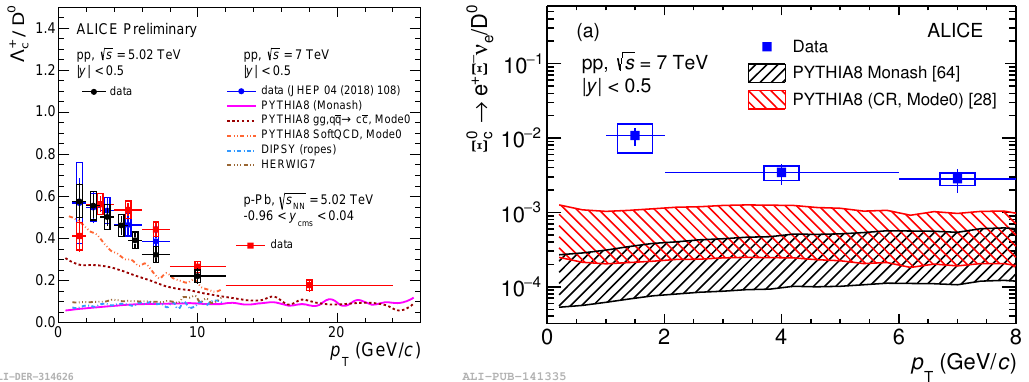
Figure 3. ( Left ) Ratios of Λ + c and ( Right ) Ξ 0 c p T -differential cross sections [13] over D 0 in pp collisions √ s = 7 TeV, compared to several theoretical calculations at